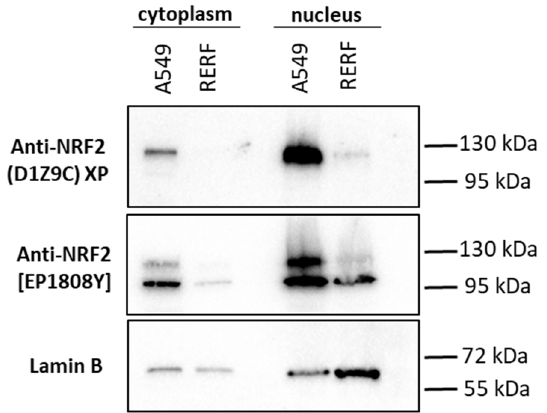
Figure 4. Western blot analysis after nuclear and cytoplasmic fractionation of A549 and RERF cells. Nrf2 was detected with two monoclonal antibodies: Cell Signaling (D1Z9C) and Abcam (EP1808Y) rabbit. Lamin B was used as a nuclear marker showing enrichment in the nuclear fraction.